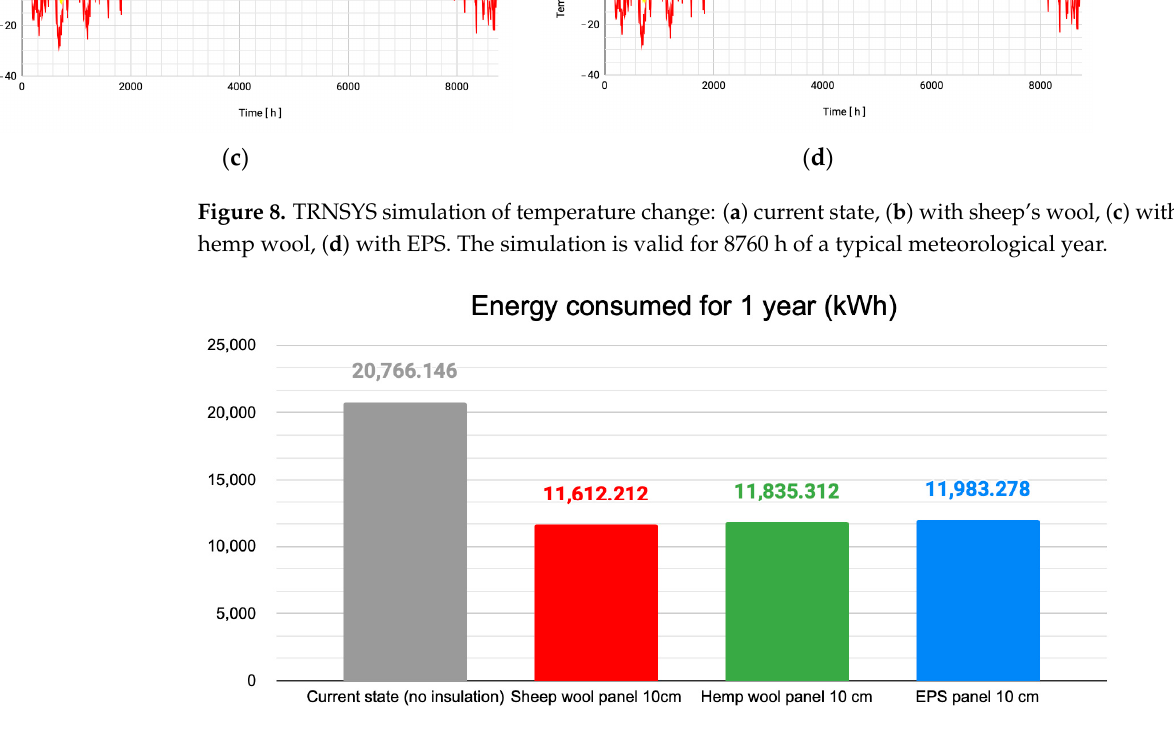
Figure 9. Energy consumed for one year (based on simulation).